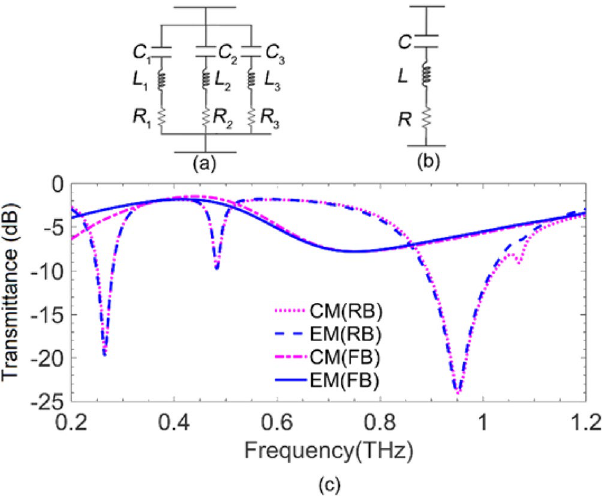
Figure 5. The equivalent circuit model of the metasurface for the ( a ) reverse and ( b ) forward bias of the Schottky, ( c ) The transmission spectra obtained from the equivalent circuit model (magenta dots and dots- dashes curve), and the full-wave simulation (blue dashed and solid curve) in the presence of the ohmic losses for reverse and forward bias cases.